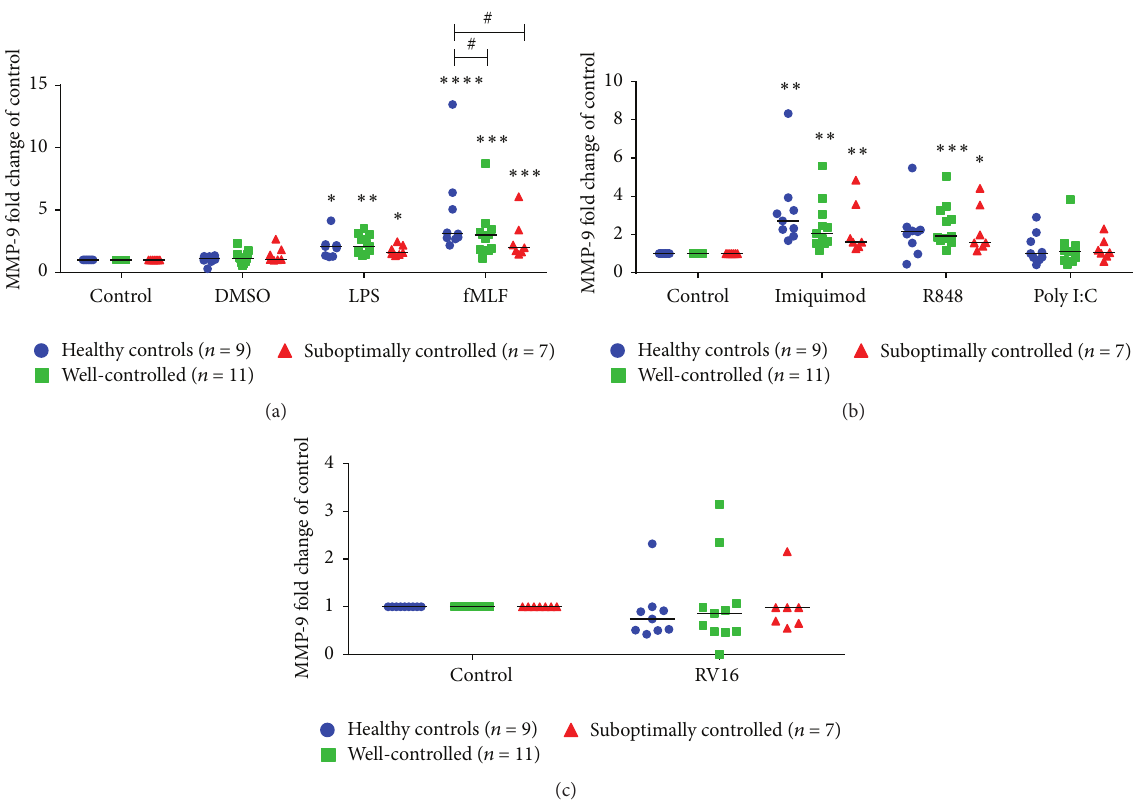
Figure 3: MMP-9release fromneutrophils stimulated with bacterial and viral mimetics and RV16. MMP-9release fromhealthy controls (blue circles, 𝑛 = 9 ), well-controlled asthmatic (green squares, 𝑛 = 11 ), and suboptimally controlled asthmatic (red triangles, 𝑛 = 7 ) neutrophils stimulated with (a) bacterial compounds: lipopolysaccharide (LPS), f-Met-Leu-Phe (fMLF), and DMSO (vehicle control), (b) viral surrogates: imiquimod, R848, and polyinosinic:polycytidylic acid (poly I:C), and (c) RV16 after 1 hour. Raw data is presented as a scatter plot with median. ∗ 𝑝 < 0.05 , ∗∗ 𝑝 < 0.01 , ∗∗∗ 𝑝 < 0.001 , and ∗∗∗∗ 𝑝 < 0.0001 compared to unstimulated control. # 𝑝 < 0.05 between indicated disease groups.